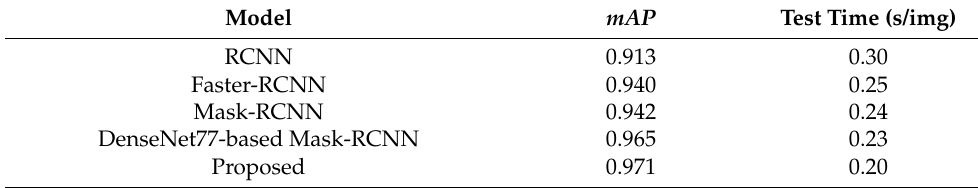
Table 3. Comparative analysis with other object detection